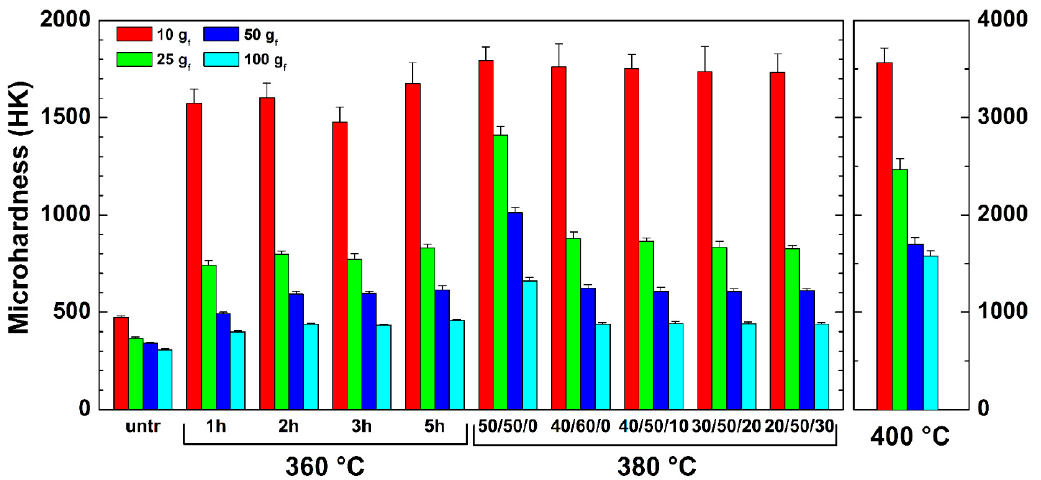
Figure 8. Surface Knoop microhardness values of samples untreated and nitrided as indicated. (For sample type, refer to Table 1).